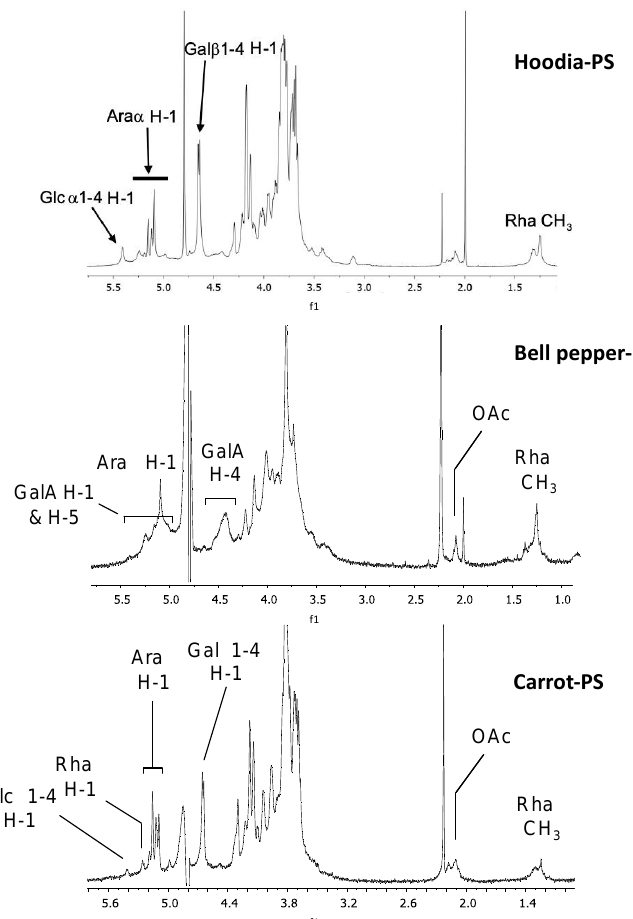
Figure 2. 1 H-NMR spectra of mildly acidic DEAE subfractions of hoodia-PS (top), bell pepper-PS (middle) and carrot-PS (bottom). Signals are assigned to rhamnosyl (Rha), galacturonyl (GalA), galactosyl (Gal), arabinosyl (Ara) and glucosyl (Glc) residues based on external standards.